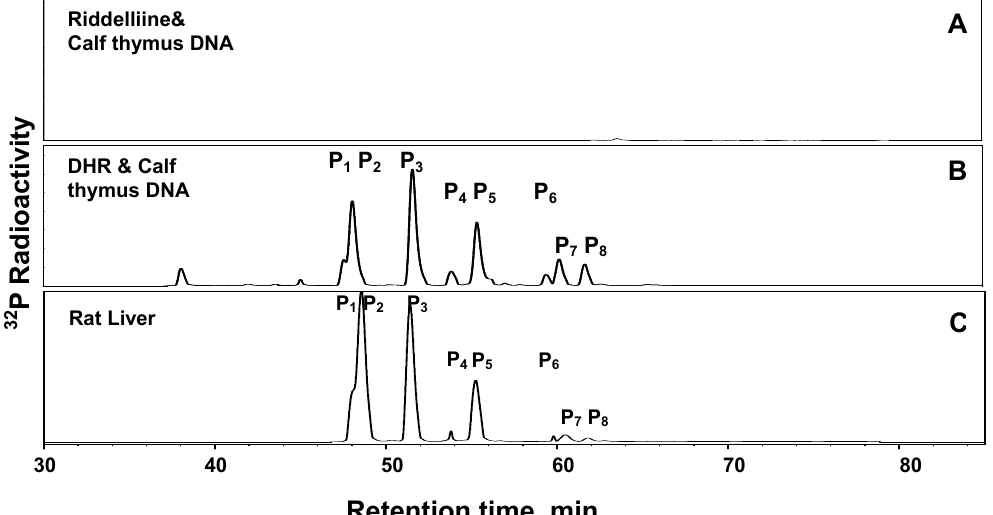
Figure 5. 32 P-Postlabeling/HPLC analysis of DHP-derived DNA adducts contained in (A) reaction of riddelliine with calf thymus DNA without microsomal activation; (B) modified DNA from reaction of DHP with calf thymus DNA; and (B) livers of rats treated orally gavaged with 1.0 mg/kg/day 5 days/week beginning at weaning and continuing until sacrifice at three months